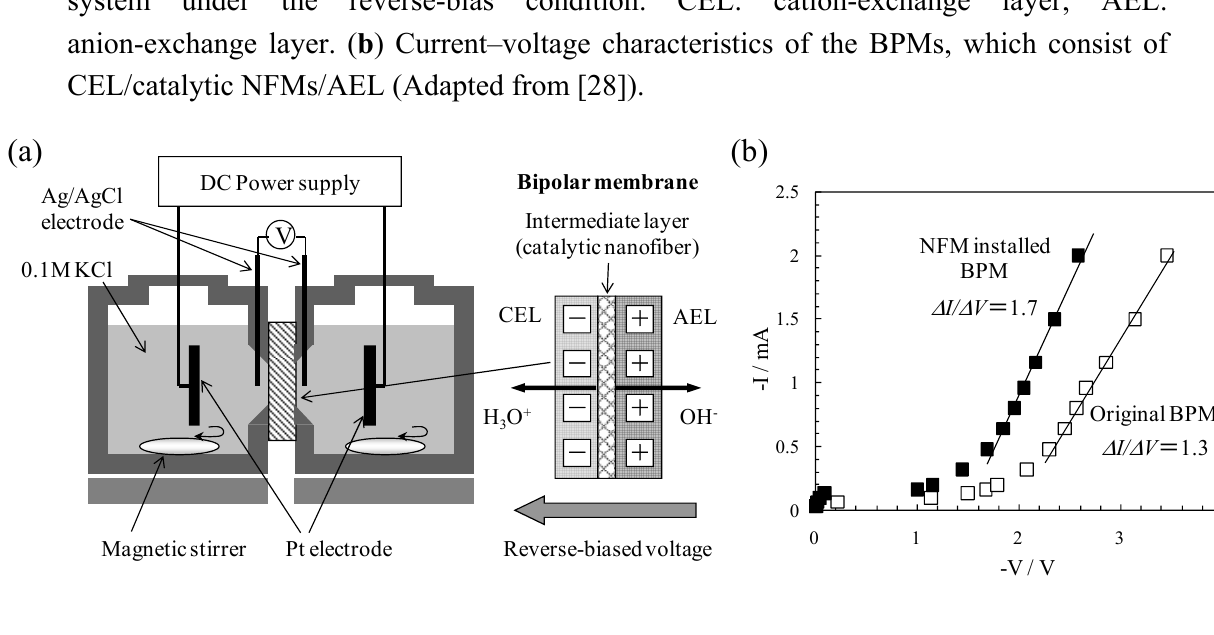
Figure 9. ( a ) Schematic diagram of apparatus for bipolar membrane (BPM) electrodialysis system under the reverse-bias condition. CEL: cation-exchange layer;